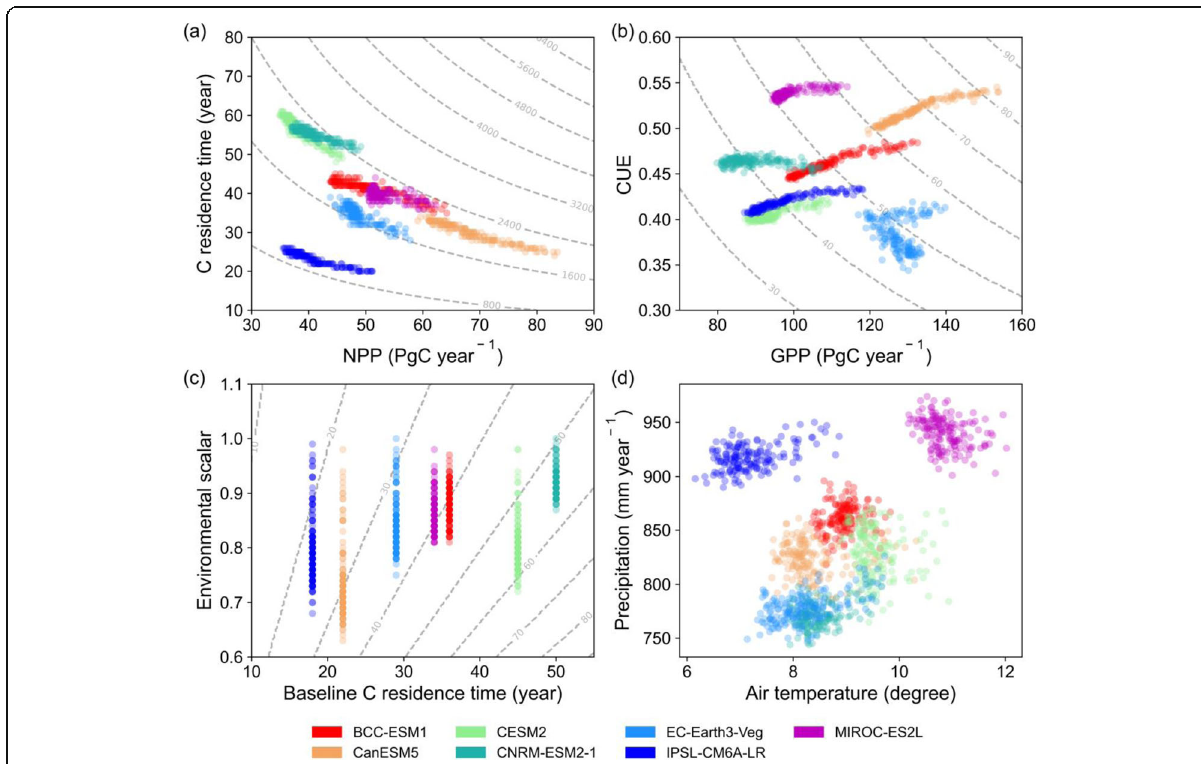
Fig. 4 The traceability decomposition of carbon storage capacity. The contours lines in a – c represent carbon storage capacity, net primary productivity (NPP), and carbon residence time respectively. Points represent the global annual values for